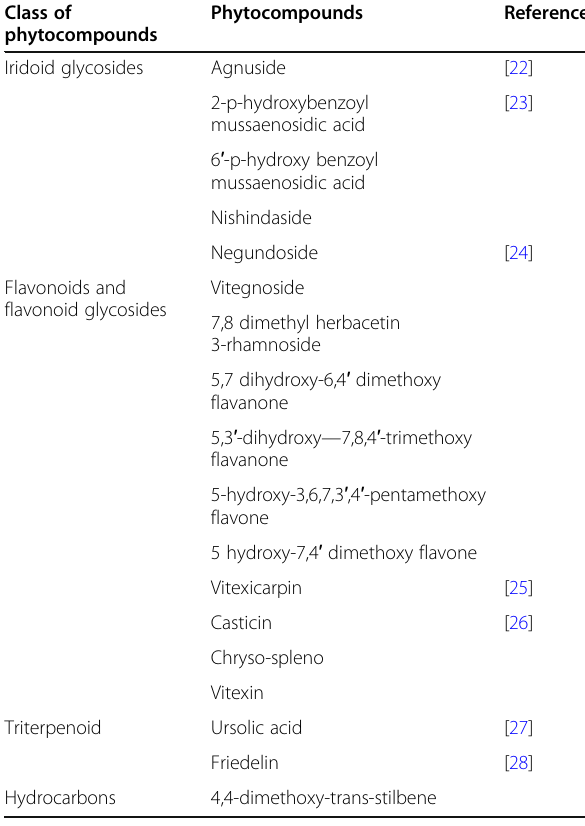
Table 1 Phytochemicals present in VN leaves Class of